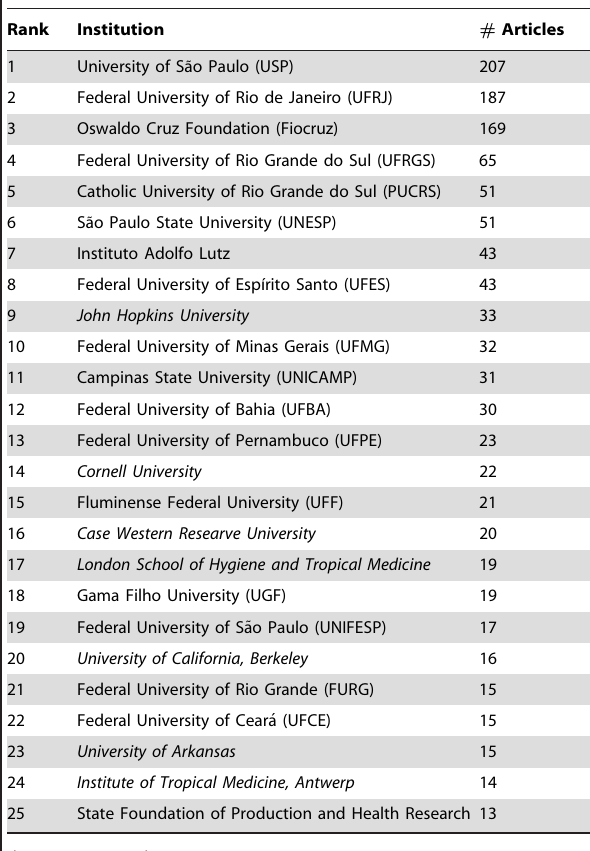
Table 3. Top 25 institutions publishing articles on tuberculosis with Brazilian authors, 1995–2010 (Foreign institutions in italics).